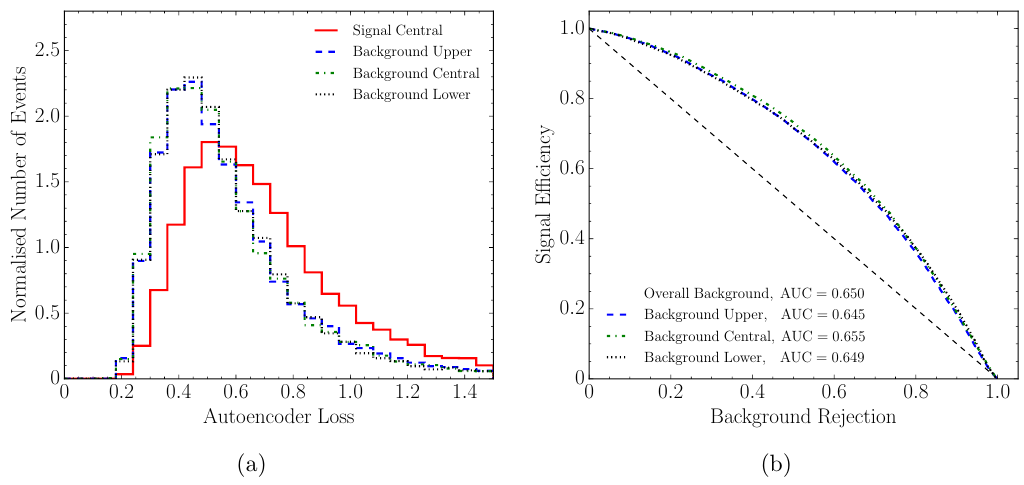
Figure 6. Autoencoder loss (a) and ROC curves (b) for an adversarial autoencoder trained only on background events. The three background distributions result from the three di(cid:11)erent directions of